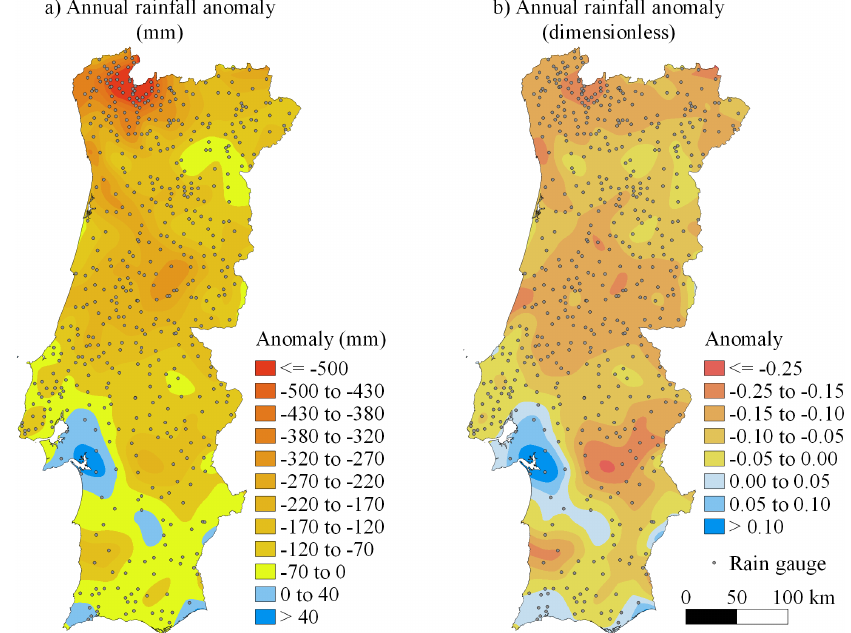
Figure 11. Mean annual rainfall anomalies: difference between mean annual rainfalls in the 51-year sub-period, from 1968/16969 to 2018/2019, and in the 55-year period, from 1913/14 to 1967/1968 ( left side ); previous difference relative to the mean annual rainfall in the 55-year initial period ( right side